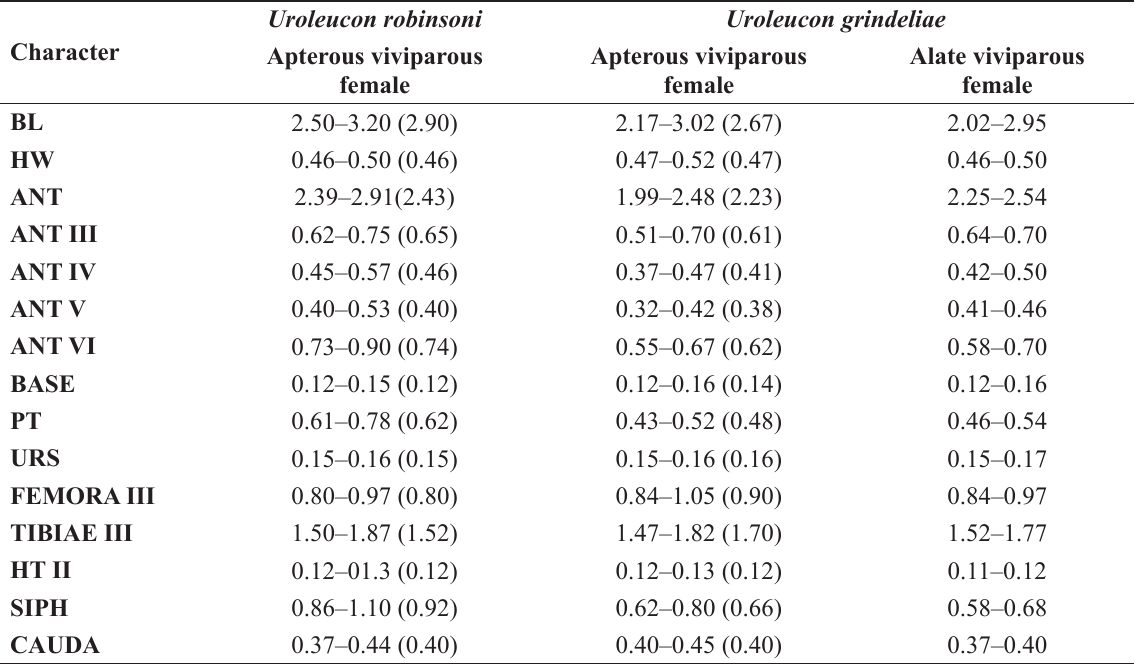
Table 1. Measurements of the known morphs of Uroleucon ( Lambersius ) robinsoni sp. nov. and U . ( L .) grindeliae sp. nov. Measurements of the holotype are given in parentheses after the